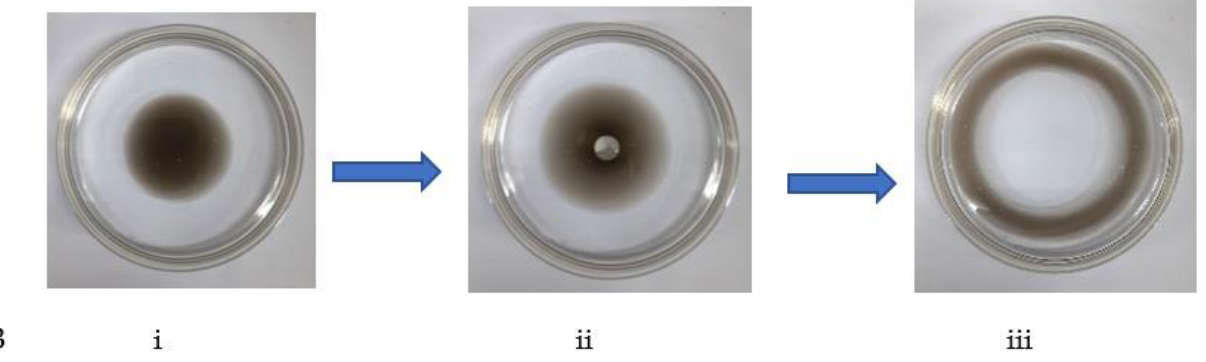
Figure 4. ( A ) Emulsification activity of recombinant iturin A: (i) test sample, (ii) negative control. ( B ) Oil spread assay: (i) motor oil before adding recombinant lipopeptide, (ii) recombinant lipopeptide added on oil surface, (iii) oil dispersion by recombinant lipopeptide.